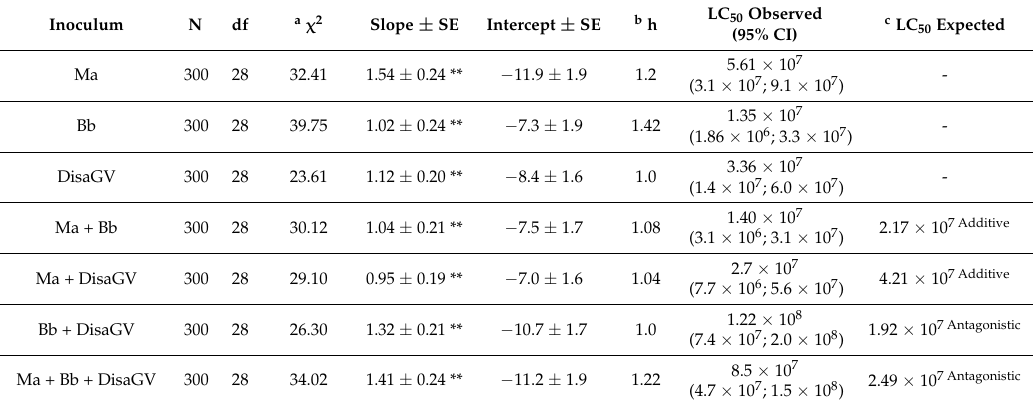
Figure 1. Percent infection attributed to each insect pathogen after a single or combined inoculation of fungal and virus pathogens on the third instar larvae of sugarcane borer after exposure to different concentrations of these pathogens. Number of larvae (n) assayed was reported for each test. Ma— Metarhizium anisopliae ; Bb— Beauveria bassiana ; DisaGV—Diatraea saccharalis granulovirus. Table 1. Estimates of median lethal concentrations ( LC 50 ) and relative potencies by fitting a logistic regression model to the concentration–mortality response data of fungal and virus pathogens, and their combinations against the third instar larvae of